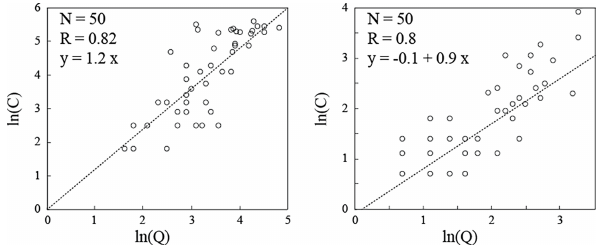
Figure 5. Logarithmic dependences of TSM concentrations ( C , gm − 3 ) on river discharge rates ( Q , m 3 s − 1 ) for the large (left) and small (right) rivers of